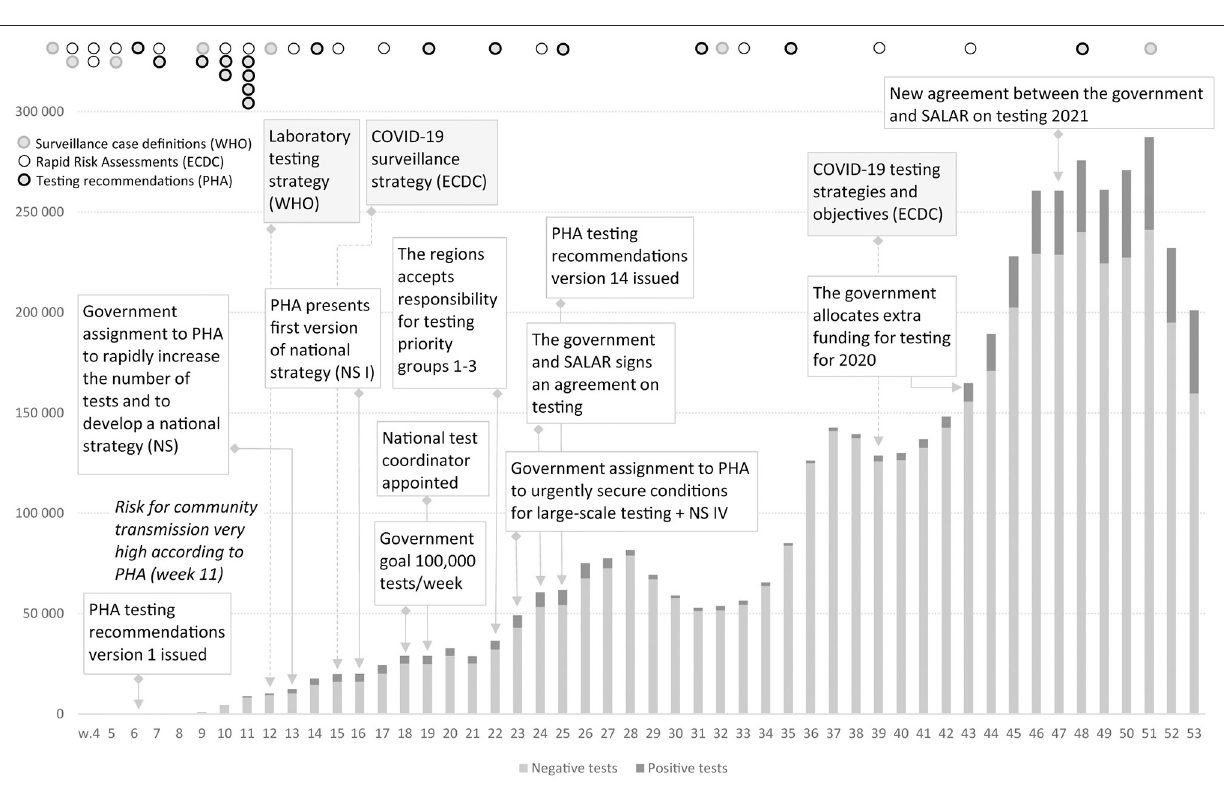
Frontiers in Public Health | www.frontiersin.org